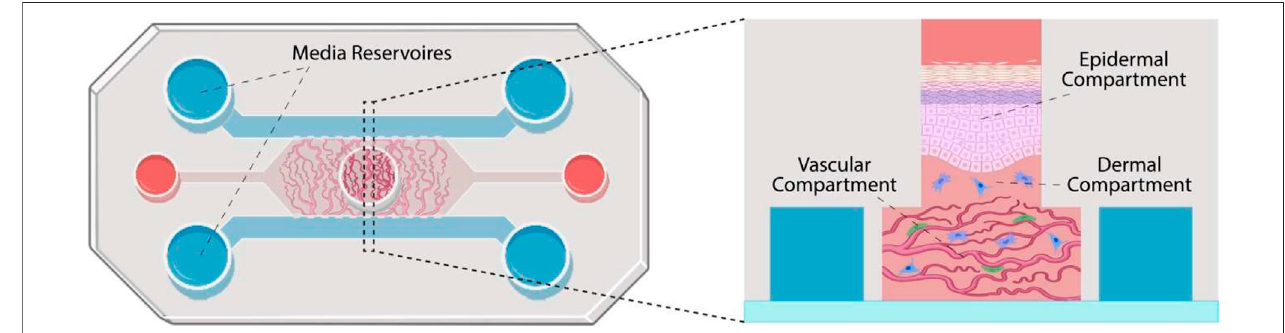
FIGURE 1 | Schematic representation of the skin-on-a-chip model proposed. The chip is constituted of three parallel channels separated by micro-posts and connectingmediareservoirs.Acentralwellispositionedinthecenterofthecentralchannel.Thevascularcompartmentisformedinthecentralchannel(microvasculature shown in red and pericytes in green). Dermal fi broblasts (in blue) are introduced within a second hydrogel compartment, in the central well, before keratinocytes are seeded and allowed to stratify (in